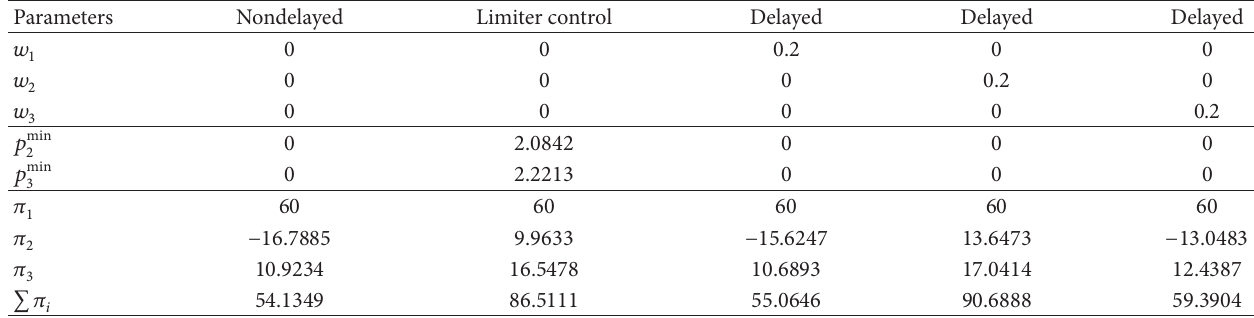
Table 2: Comparative analysis of oligarchs’ profits when 𝛼 = 0.5 , 𝛽 = 0.32 , and 𝛾 = 0.2 .